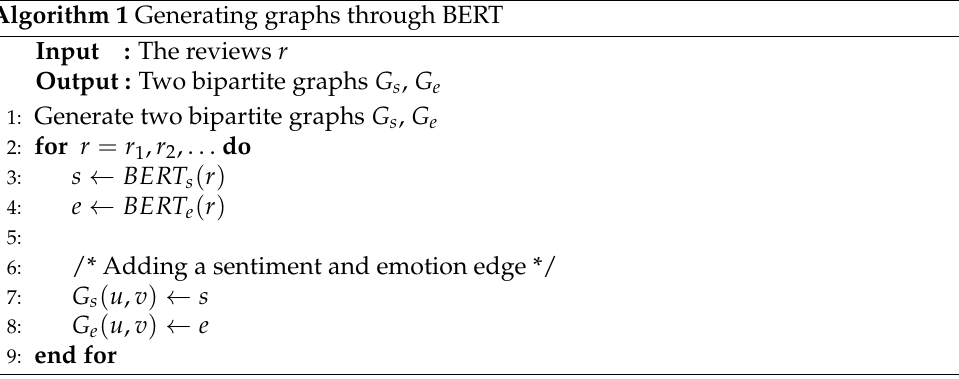
Figure 3. Aggregated subgraph embedding reflecting Cinematic Experience. Algorithm 1 Generating graphs through